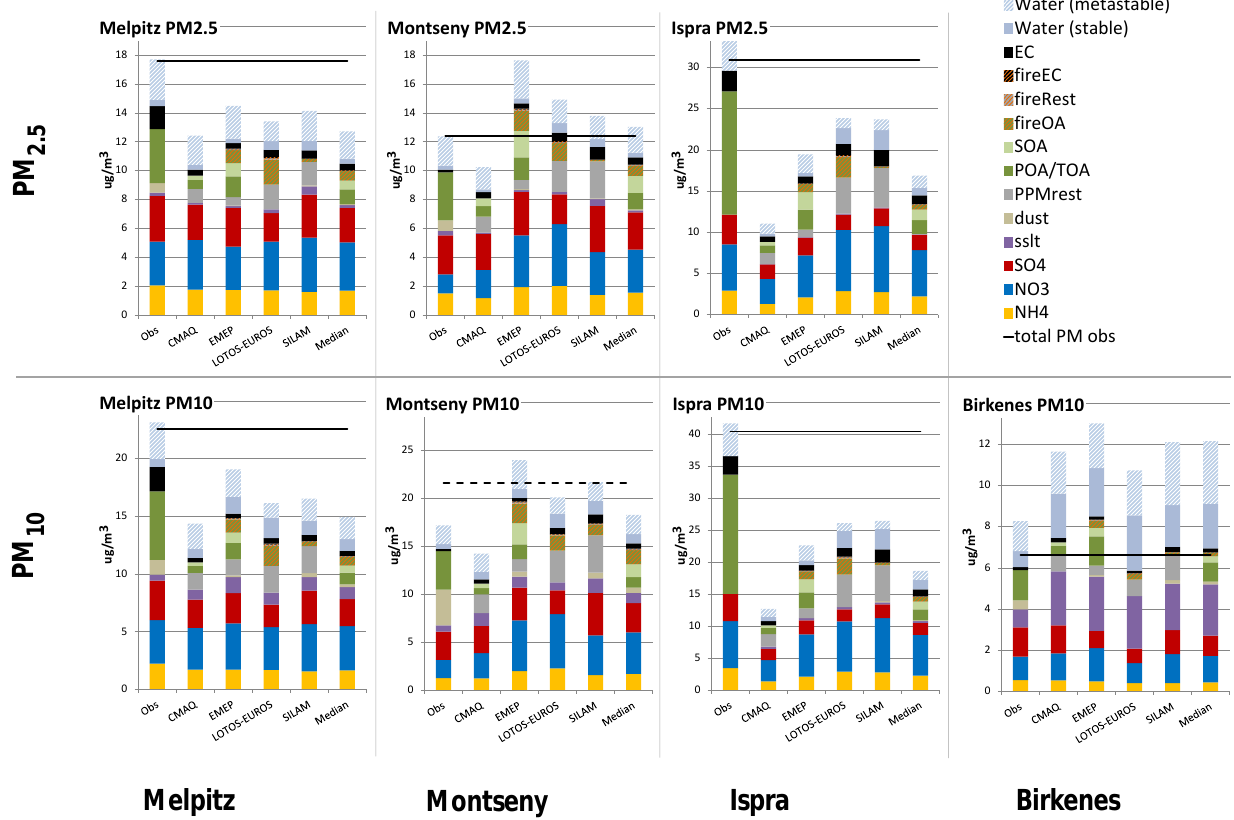
Figure 8. Aerosol chemical composition measured and modelled at four stations. Upper row – PM 2 . 5 , lower row – PM 10 . Water – aerosol water content at 50% RH and 20 ◦ C, computed with ISORROPIA2 based on observed or modelled aerosol composition. metastable – particle is assumed to be in supersaturated liquid state if the relative humidity is below its deliquescence point. stable – particle is assumed solid if the relative humidity is below its deliquescence point. EC – elemental carbon from anthropogenic emissions. fireEC – elemental carbon from wild-land fire emissions, 5% of fire-emitted PM. fireRest – mineral PM from wild-land fire emissions, 5% of fire-emitted PM. fireOA – organic aerosol from wild-land fire emissions, 90% of fire-emitted PM. SOA – secondary organic aerosol. POA/TOA – the primary part of organic aerosol for the models, total organic aerosol for the observations (OC × 1.6). PPMrest – the unspeciated part of the modelled primary anthropogenic PM. Dust – modelled desert dust, observed non-sea-salt Ca 2 + × 10. Sslt – sea salt, observed Na + + Cl − . SO 4 , NO 3 , NH 4 – secondary inorganic aerosols. Total PM obs – observed total PM 2 . 5 and PM 10 . * PM 10 observations were not available for Montseny station. The dotted line marks an estimate calculated by averaging PM 10 observations from the nearest EMEP stations (ES0010R, ES0014R). * Na observations were not available in Ispra and were excluded from ISORROPIA